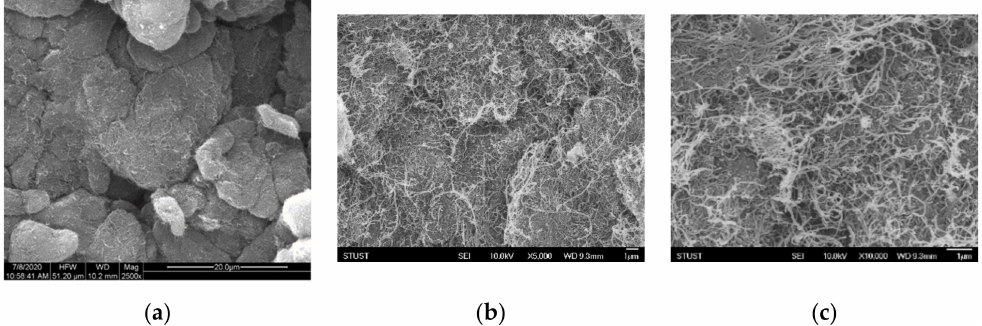
Figure 10. Scanning electron microscopy (SEM) images of the original MWCNT at magnifications of ( a ) 2500 × , ( b ) 5000 × , and ( c ) 10,000 × .